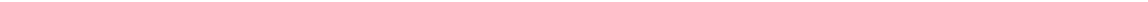
Fig. 5 Knockdown of CSDE1 impairs post-transcriptional regulation of FABP7 and VIM. a Polysome pro fi les indicate no differences in the ribosome pool upon CSDE1 knockdown (graph is representative of 3 independent experiments). b Western blot analysis with antibodies to CSDE1, OCT4, PAX6, FABP7 and VIM of H9 hESCs daily monitored to remove differentiated cells. β -actin is the loading control. c Graph (relative expression to NT shRNA H9 hESCs) represents the mean ± s.e.m. of three independent experiments with three biological replicates. d Ribonucleoprotein immunoprecipitation (RIP) with CSDE1 antibody. Quantitative PCR analysis of the indicated genes is expressed as fold enrichment over RIP performed with FLAG control antibody. Graph (relative enrichment to FLAG antibody) represents the mean ± s.e.m. ( n = 4 independent experiments). e mRNA levels were determined after the indicated time of actinomycin D (ActD) treatment (5 μ g ml − 1 ) by qPCR. For each gene, the right graph corresponds to a representative experiment showing the percentage independent experiments). The time course experiments with ActD treatment were established for every gene depending on the mRNA degradation